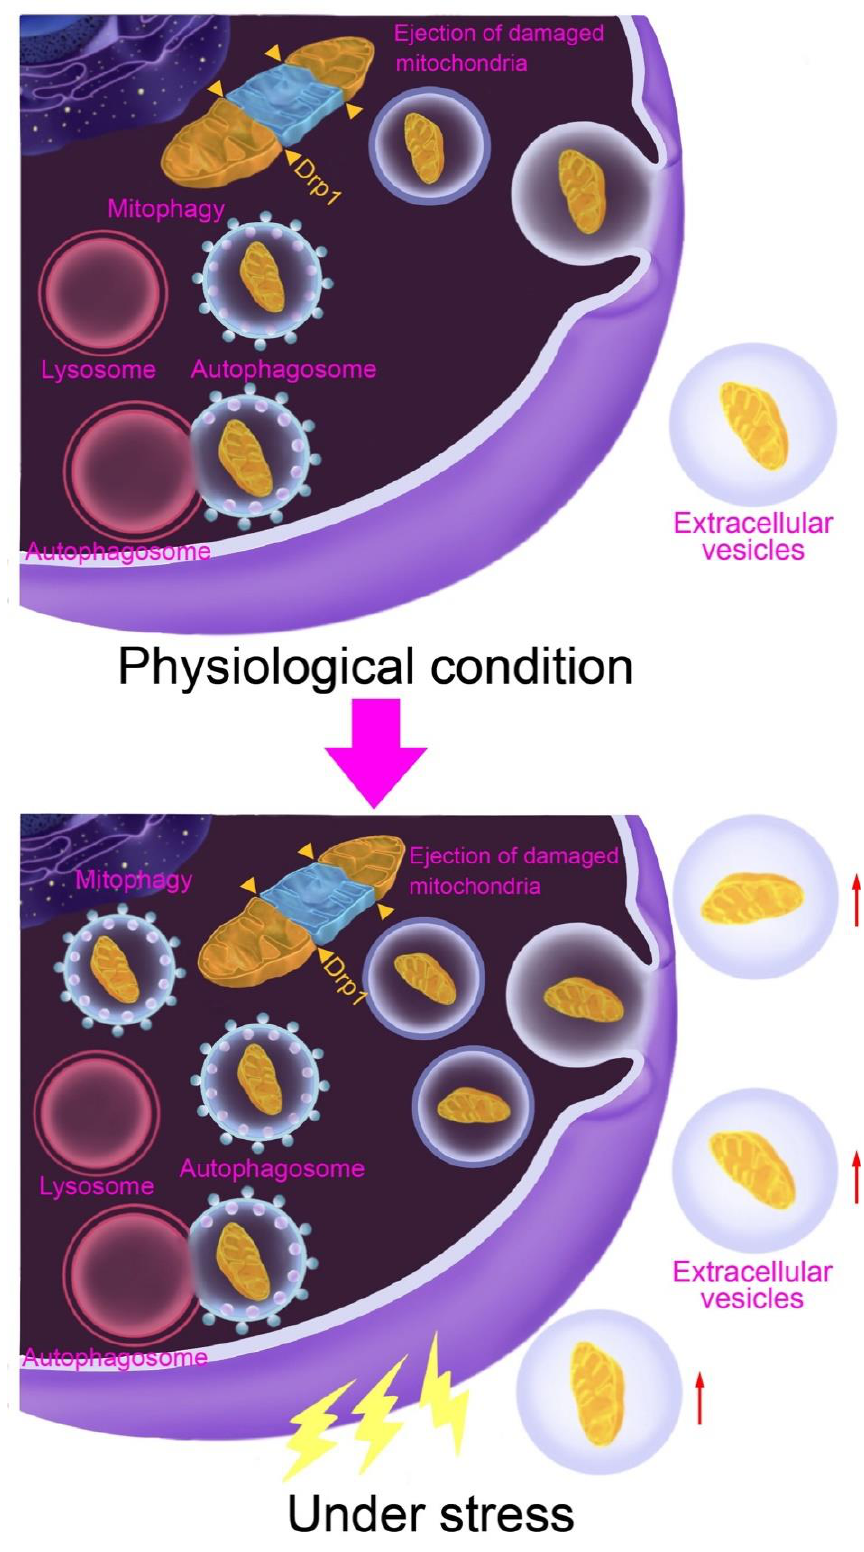
Figure 3. Schematic hypothetical model of the mitochondrial quality control system in cardiomyocytes. Under physiological conditions, both the intracellular mitochondrial quality con- trol systems, such as mitophagy, and extracellular mitochondrial ejection equivalently contribute to the removal of damaged mitochondria. However, the demand for extracellular clearance of dam- aged mitochondria is markedly increased under stress conditions in cardiomyocytes. Explanation red arrow: